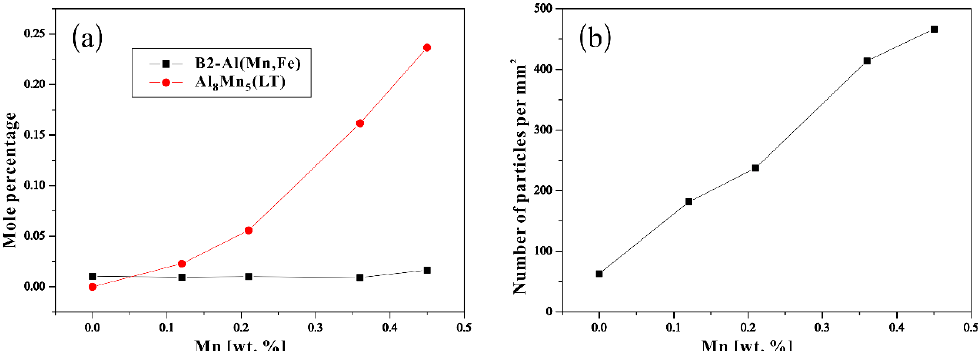
Figure 11. ( a ) Predicted mole percentage of B2-Al(Mn,Fe) and Al 8 Mn 5 (LT) by Scheil solidification in different Mg-3Al- x Mn alloys. ( b ) The statistic number of particles per mm 2 in the Mg-3Al- x Mn alloys based on low magnification EPMA images.